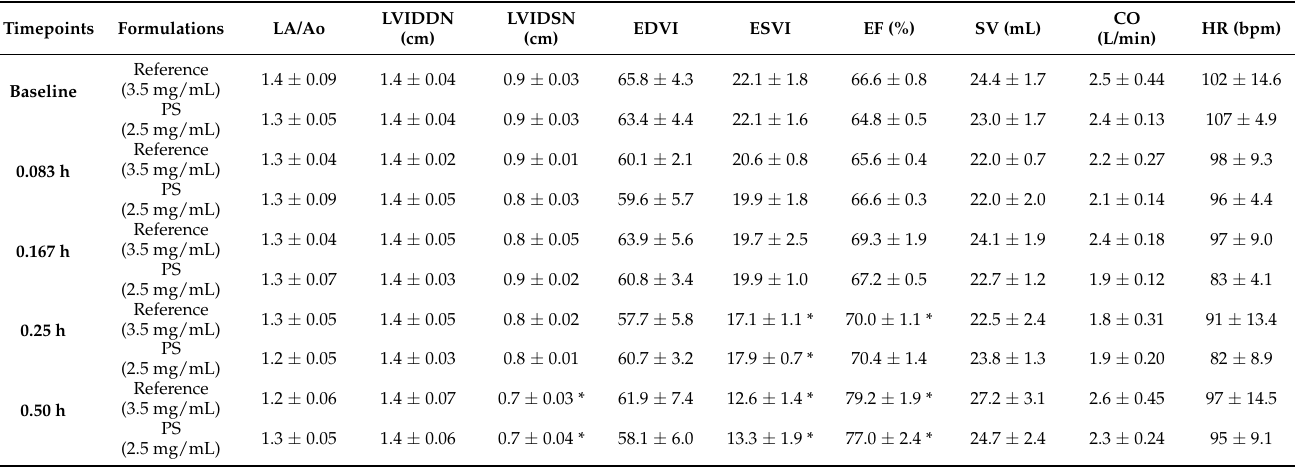
Table 2. Comparison of the cardiac effects of pimobendan (0.3 mg/kg) for both reference solution formulation (3.5 mg/mL) and pimobendan oral solution formulation (2.5 mg/mL) on the echocardio- graphic parameters in healthy beagle dogs (n = 4 for each